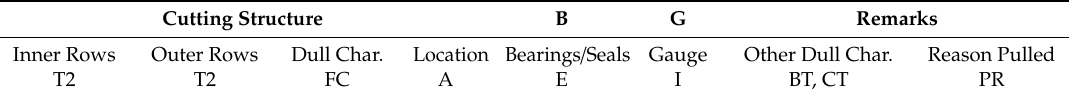
Figure 6. Estimated value shear stress–normal stress for limestone.